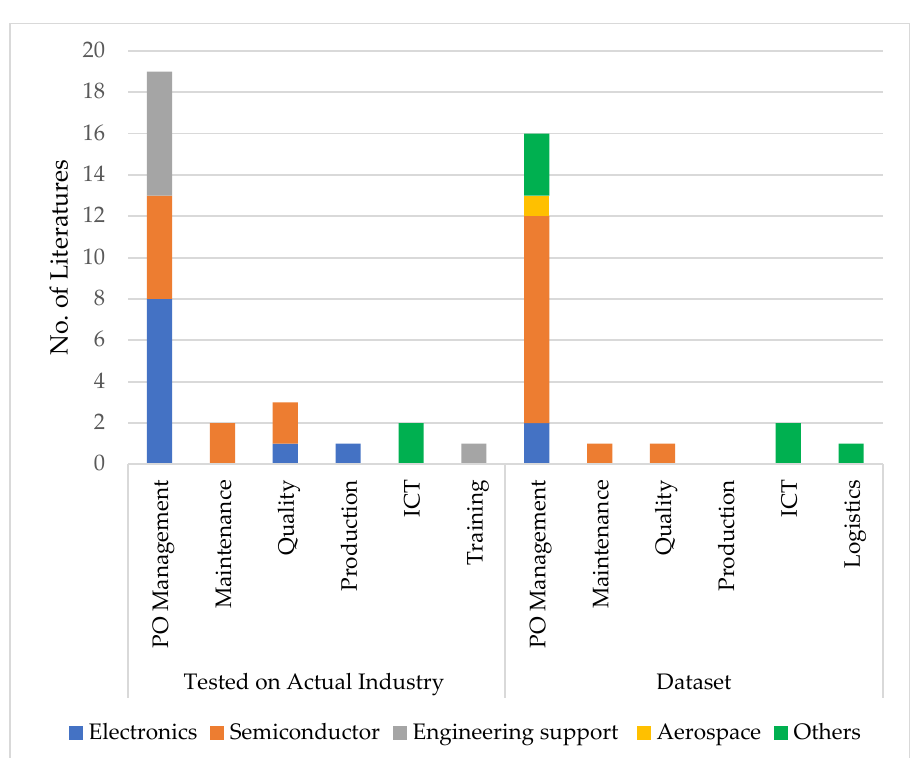
Figure 11. Types of industrial validation according to research area and industrial sectors .